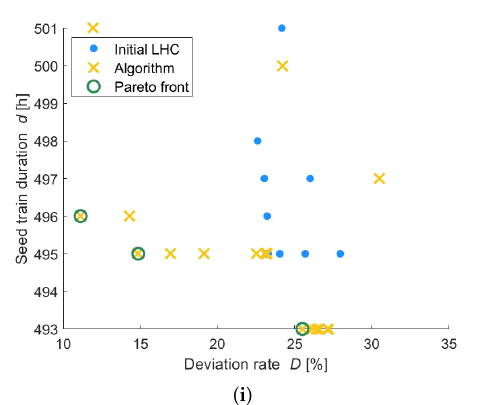
Figure A1. Pareto solutions for 3, 4 and 5 shake flask scales and for three different growth rates, reference maximum growth rate (left column), a 5% lower (middle column) and a 5% higher growth rates (right column) showing the objective criterion seed train duration over objective criterion deviation rate, using 20 optimization iterations; Blue dots: based on the initial Latin hypercube (LHC) design; Yellow crosses: based on the proposed points (by the algorithm); Green circles: Pareto optimal solutions. ( a ) 5 sf, µ ,max,ref . ( b ) 5 sf, µ ,max,95% . ( c ) 5 sf, µ ,max,105% . ( d ) 4 sf, µ ,max,ref . ( e ) 4 sf, µ ,max,95% . ( f ) 4 sf, µ ,max,105% . ( g ) 3 sf, µ ,max,ref . ( h ) 3 sf, µ ,max,95% . ( i ) 3 sf, µ ,max,105%